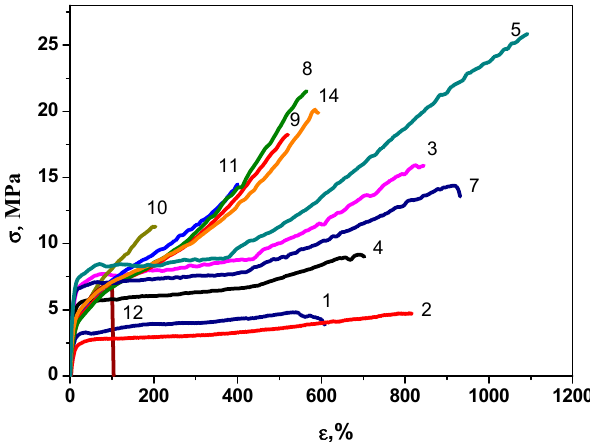
Figure 5. Stress–strain diagrams for E/P samples 1–5, 7 and E/P/ENB samples 8–12, 14, produced by rac -Et(2-MeInd) 2 ZrMe 2 /isobutylaluminum aryloxide catalytic systems. Aryloxides are 1,8—1-DTBP; 2,9—1-BHT, 3,10—1-TTBP; 7,14—1-DPP; 4,11—2-DTBP, 9,12—2-BHT.